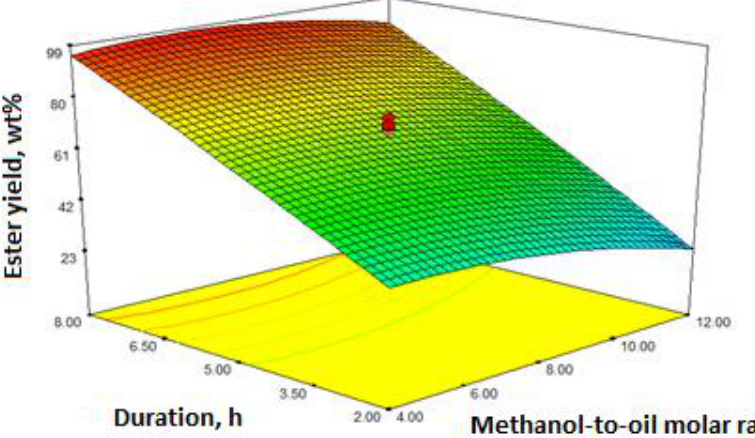
Figure 3. Response surface contour plot for the interaction between the methanol-to-oil molar ratio and the process duration at a temperature of 64 °C with a catalyst content of 5 wt%.